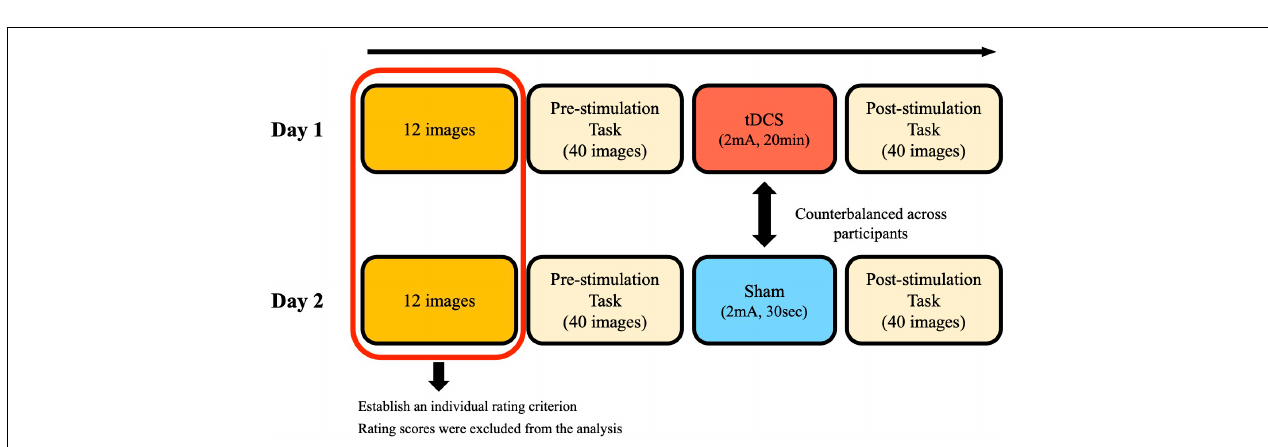
FIGURE 2 | Red crosses in both panels represent mean rating scores of images in Experiment 1. Individual rating scores are plotted in the upper panel. Representative rated images at each data point are shown in the bottom panel. Error bars represent standard deviations (SD) of rating scores.